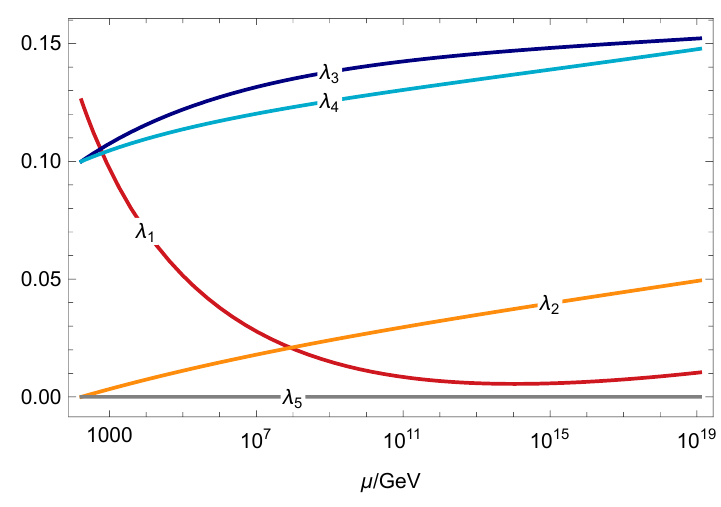
Figure 2 . The running scalar couplings as functions of the renormalization scale µ for the initial conditions λ 2 = λ 5 = 0 , λ 3 = λ 4 = 0 . 1 given at the scale m t